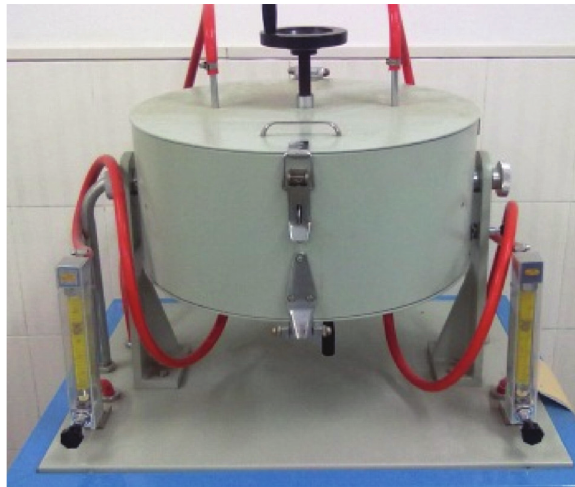
Figure 2 DRP-6W flat-panel thermal conductivity tester.